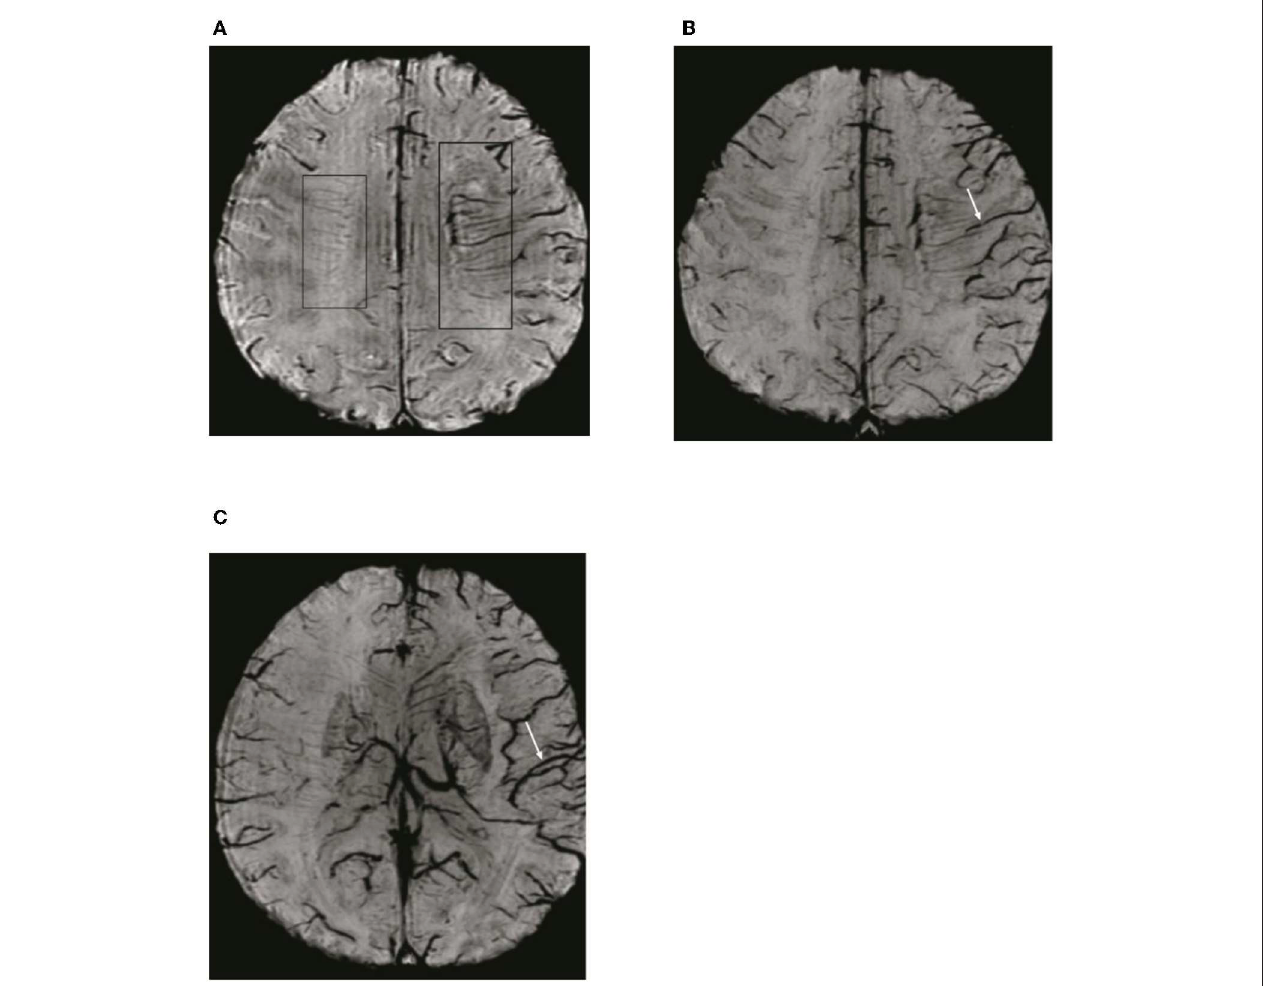
FIGURE 2 | Illustration of asymmetric deep medullary veins (ADMV) and asymmetric cortical veins (ACV). (A) A greater number and diameter of deep medullary veins is seen in the left hemisphere than in the right hemisphere; this was defined as presence of ADMV. (B,C) Cortical veins of the left hemisphere were present in greater number and diameter in the regions of M1, M2, M3, I, M4, M5, and M6 than in the right hemisphere and was defined as ACV with a score of 7.